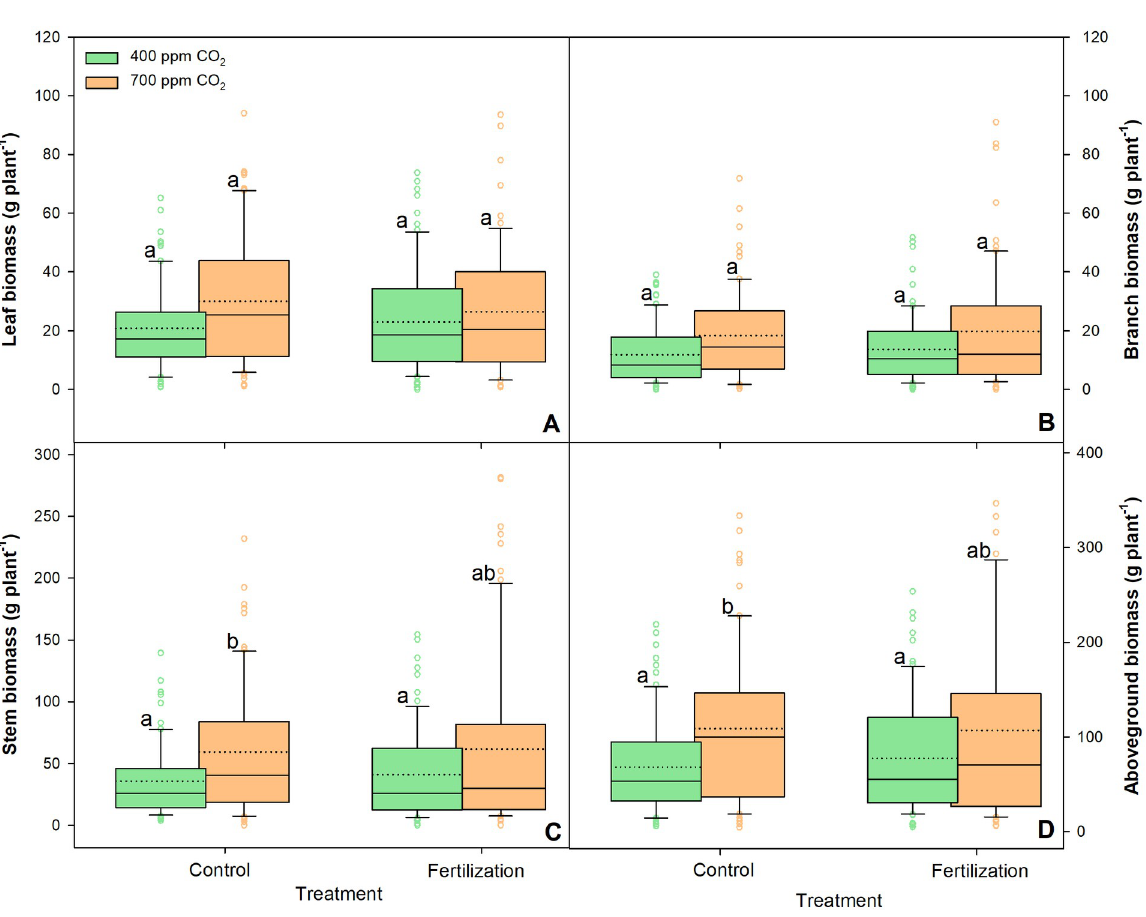
Fig 2. Changes in leaf biomass (A), branch biomass (B), stem biomass (C), and above-ground biomass (D) of sessile oak saplings (n = 72) treated under ambient (400 ppm CO 2 ) and elevated (700 ppm CO 2 ) and different nutrient supplies. The data are expressed as medians (solid lines) and means (dotted lines) of measurements. The box boundaries mark the 25 th and 75 th percentiles and whiskers the 10 th and 90 th percentiles. Circles marks outliners. Different letters indicate significant differences (p � 0.05) estimated on the basis of Duncan’s ANOVA post- hoc